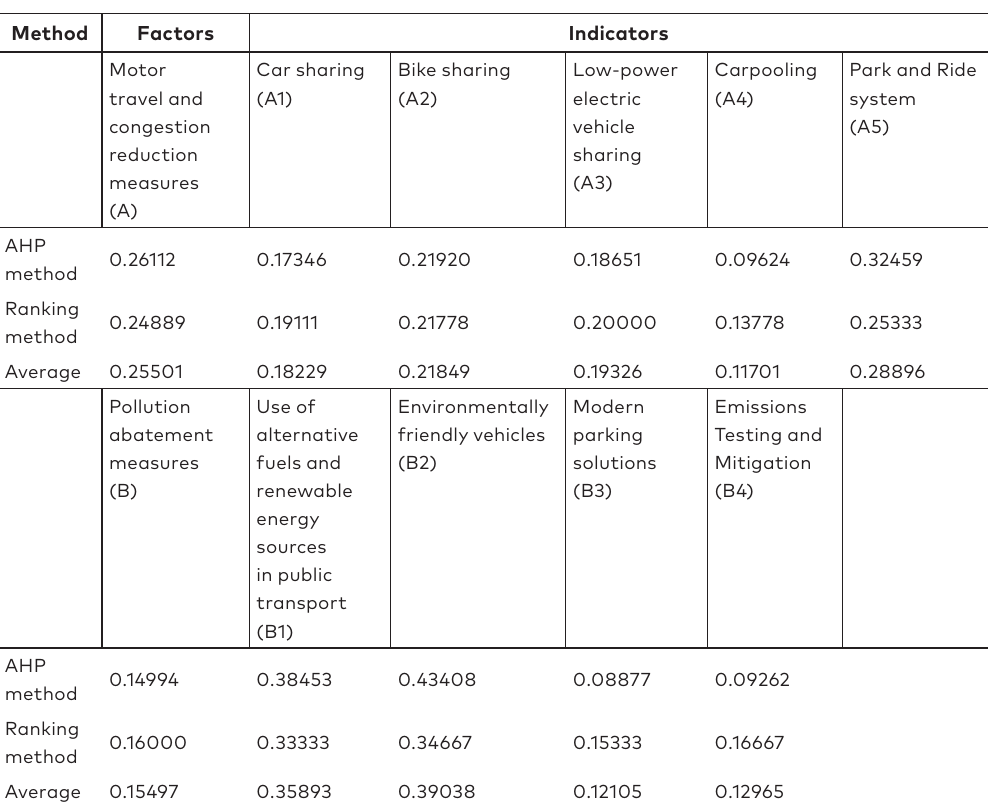
Table 7. Summarised criteria weights based on